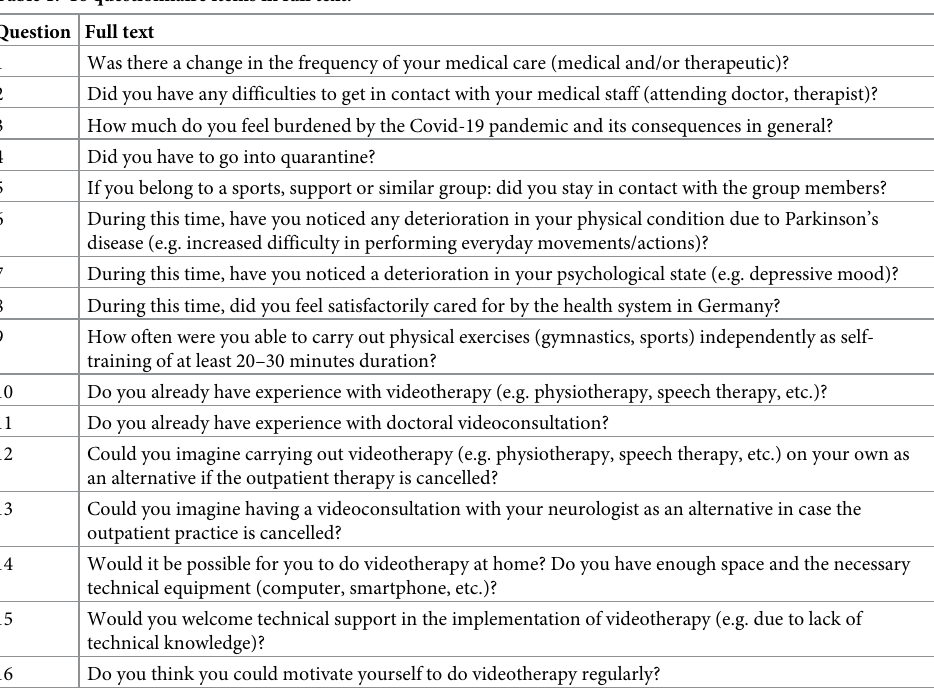
Table 1. 16 questionnaire items in full